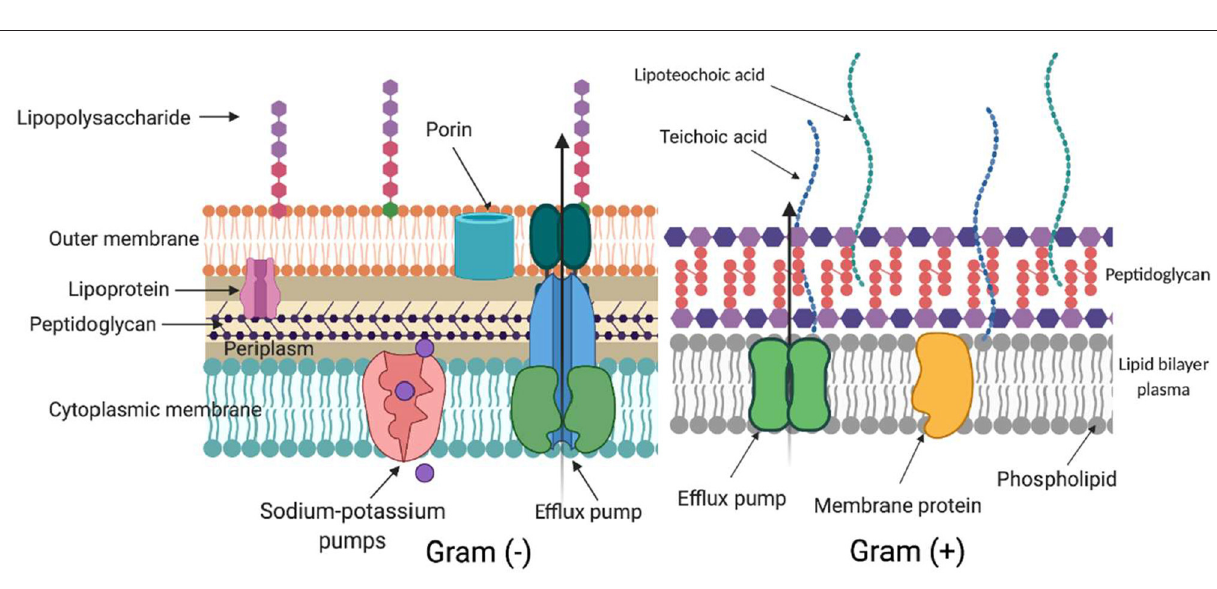
Subsequent applications of blue light (405 nm) to subcultured generations of S. aureus (ATCC 25923) were increasingly useful through four cycles; however, beginning with the 5th cycle, the effectiveness of phototreatment decreased (24). In turn,